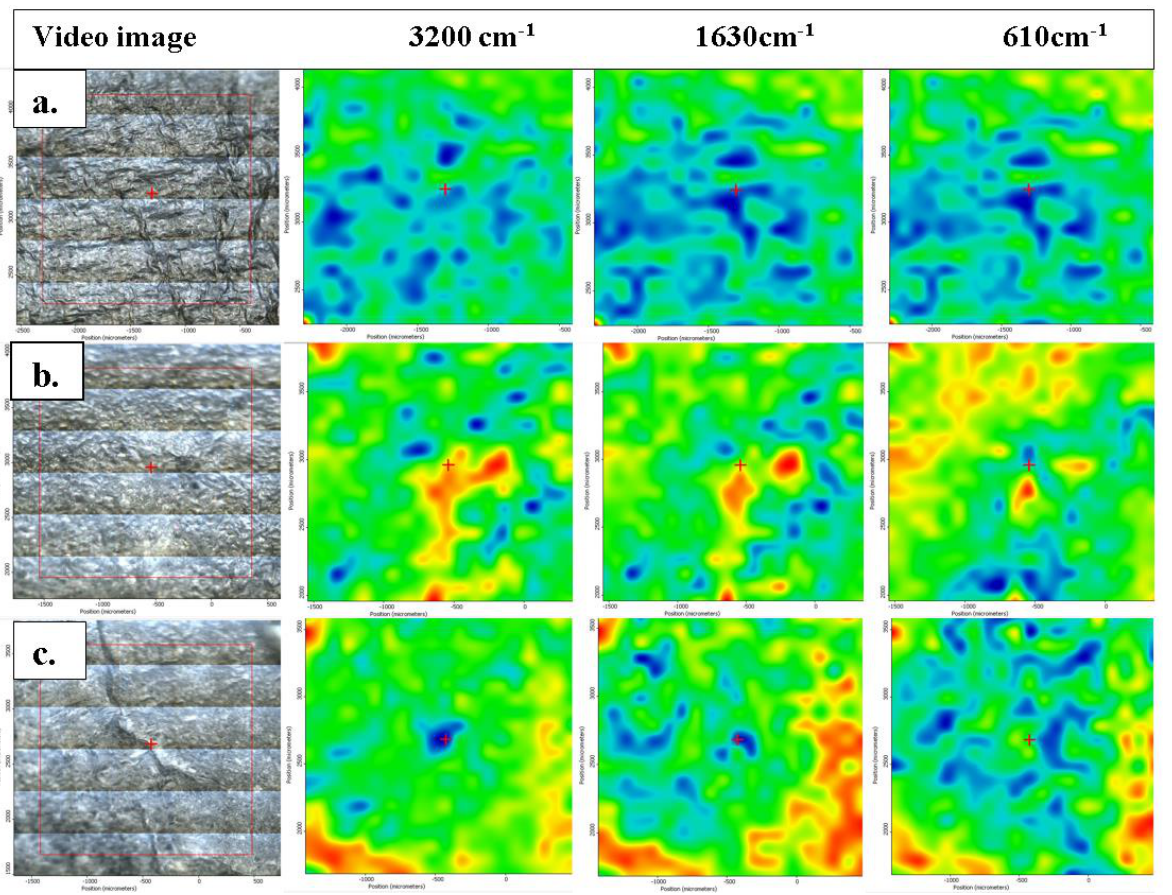
Figure 3. FTIR microscopy images recorded of the samples: ( a ) CS 3%; composite membranes ( b ) chitosan/TiO 2 1% and ( c ) chitosan/TiO 2 5%;the red indicates the zones with high absorbance, while the blue corresponds to the zones with low